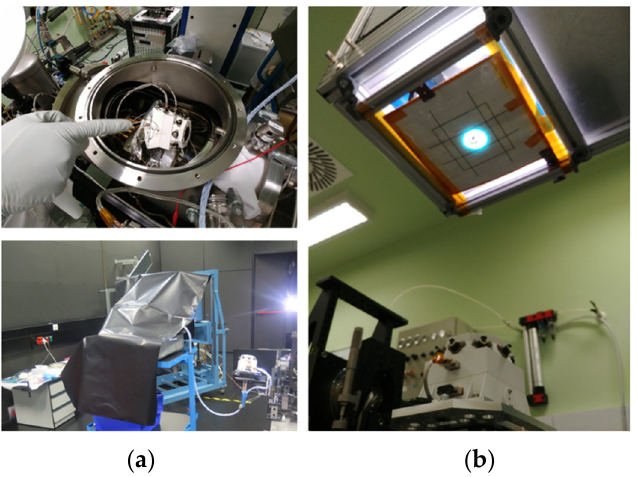
Figure 18. ( a ) On top, the RDS offset and TRF calibration set-up. On the bottom, the RDS angular calibration. ( b ) RDS responsivity calibration.